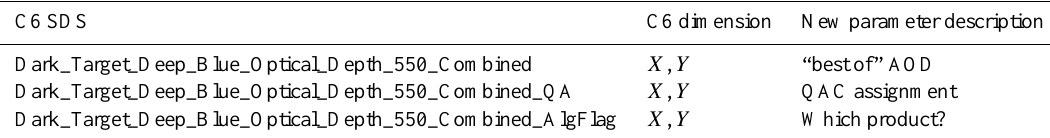
Table 7. C6 New combined Dark Target/Deep Blue SDSs.